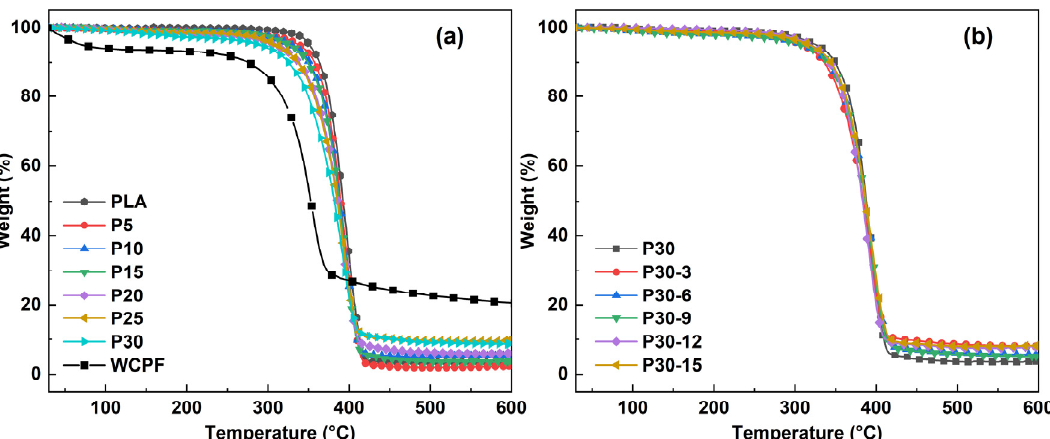
Figure 4. ( a ) TG curves of WCPF, PLA, and WCPF/PLA composite with different contents of WCPF. ( b ) TG curves of the WCPF/PLA composite with 30 wt% WCPF treated by different contents of KH-550 coupling agent.